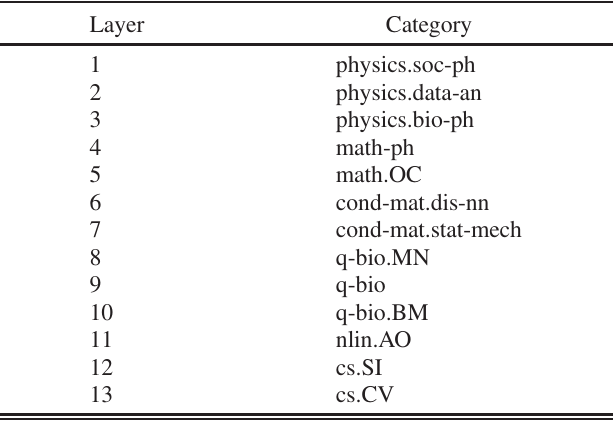
TABLE II. The arXiv repository: Each category defines a layer in the multilayer co-authorship